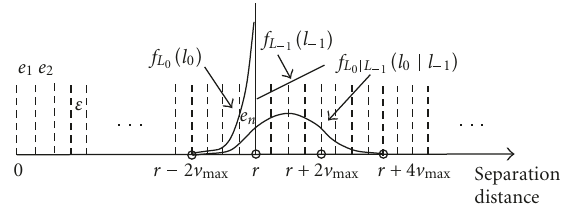
Figure 4: Depiction of PDFs of node separation, with respect to separation distance state space, at epochs − 1 and 0, taking into ac- count moves that do and do not result in a link being established. Nodes are assumed to be uniformly